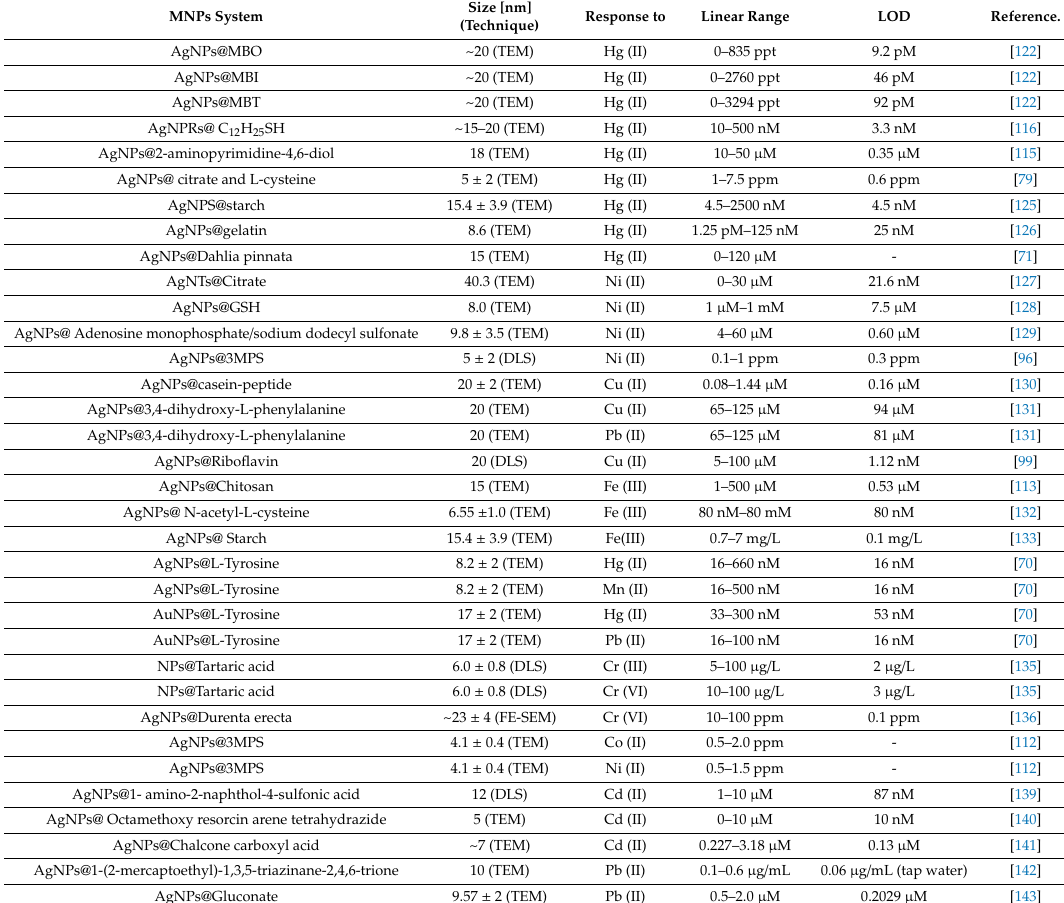
Table2. ListofAgNPssystemsasopticalsensorsforheavymetaliondetection: sizeandsensingfeatures.